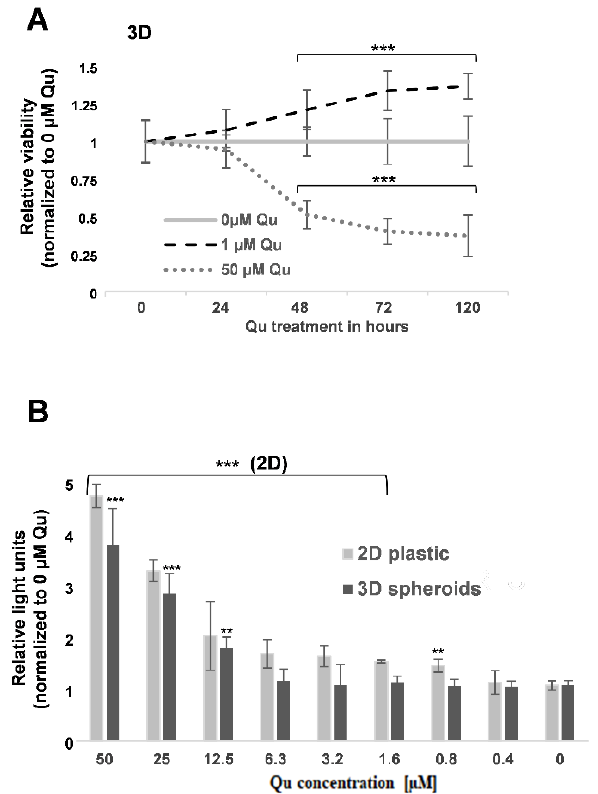
Figure 3. Effect of quercetin on cell viability in 3D human melanoma cell lines. ( A ) MCM DLN spheroids were treated on day 4 with 0, 1, or 50 µ M of quercetin, and the cell viability was assessed every day for five days using Presto blue. ( B ) Two dimensional cell culture on plastic and melanoma spheroids on were treated day 4 with 50–0.4 µ M of quercetin or left untreated, and the Caspase 3 activity (luminescence) was measured 24 h later. The data are normalized to the cell number (2D) or spheroid area (3D), the equivalent solute concentration, and to the non-treated cells. The experiments were performed at least four times in sextuplicates and are expressed as the mean ± S.D. The p- values are expressed as ** p < 0.01, and *** p < 0.001, compared to the control (0 µM).